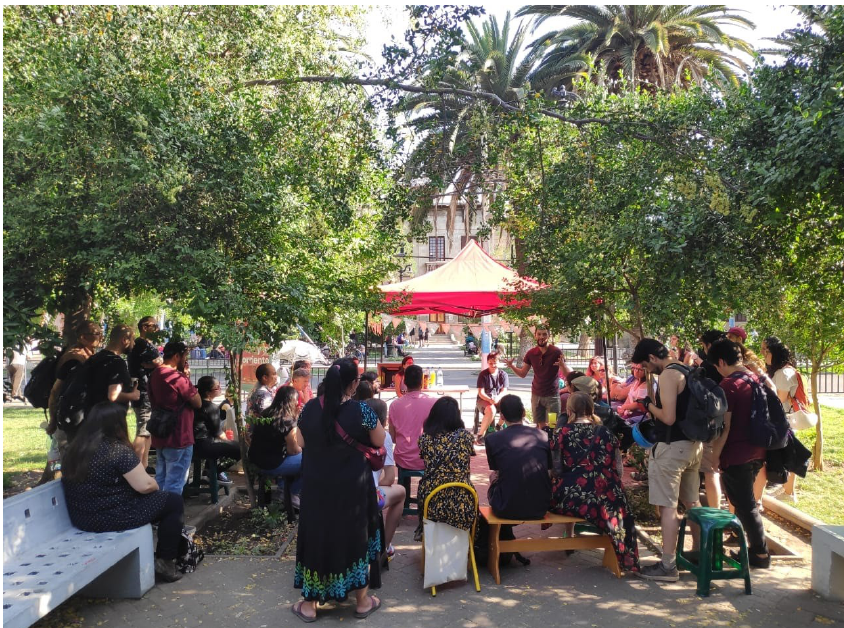
23 November 2019 – Plaza Huemul – Workshop organised by the Huemul Assembly on ‘The Constitution We Have, The Constitution We Want’ (Source: Asamblea Huemul).